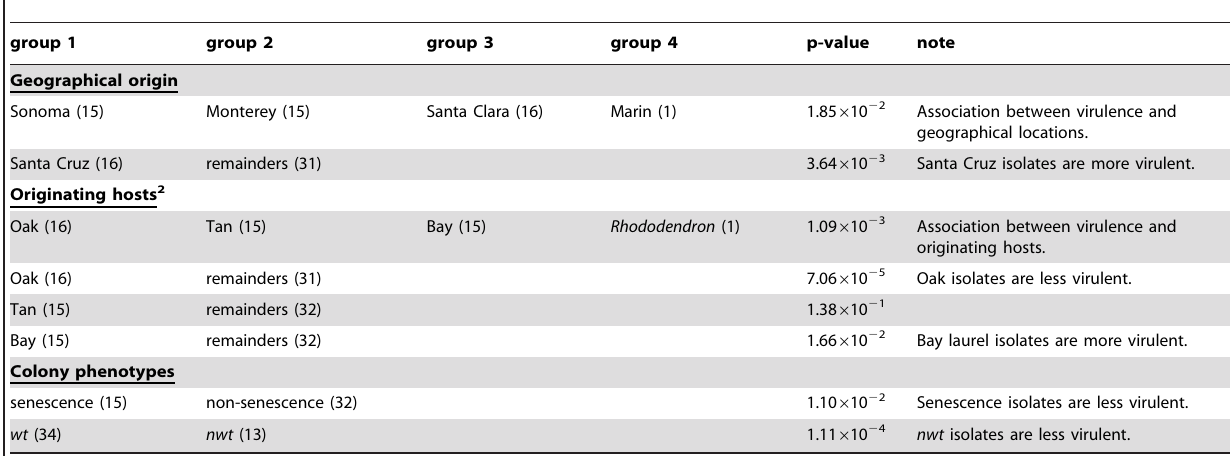
Table 3. Association of lesion size on oak and P. ramorum groups according to Kruskal-Wallis rank sum test 1 .